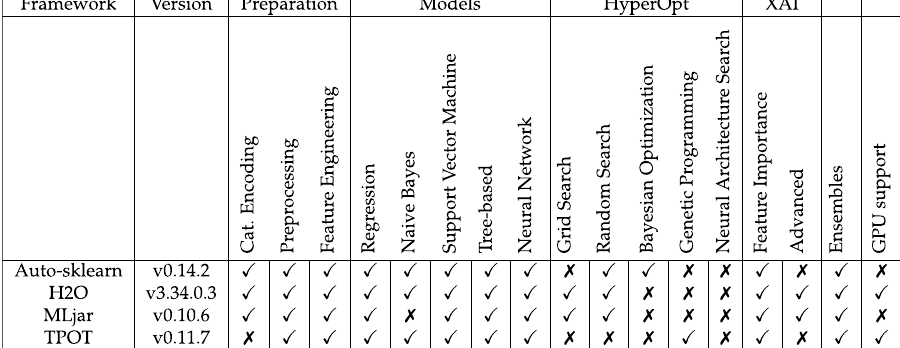
Table 3. Features of the applied AutoML